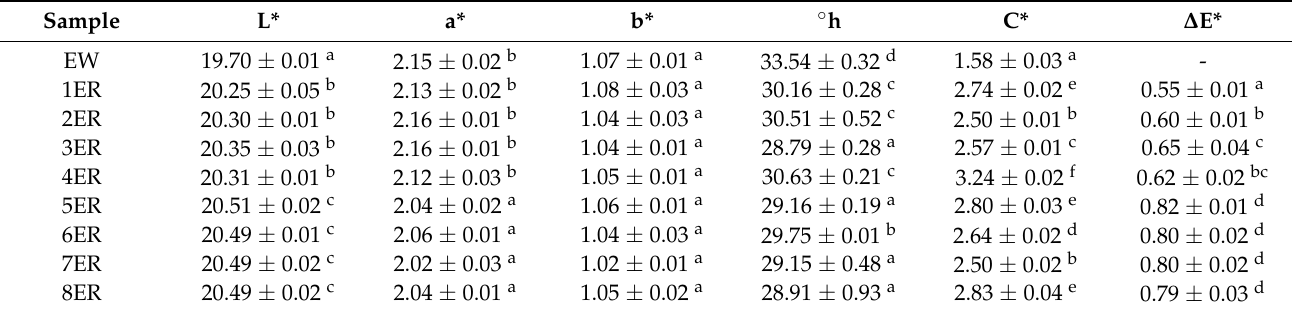
Table 11. Colour parameters (L*, a*, b*, ◦ h, and C*) in initial ecological Cabernet Sauvignon red wine and retentates obtained by reverse osmosis at 2.5, 3.5, 4.5, and 5.5 MPa with cooling and without